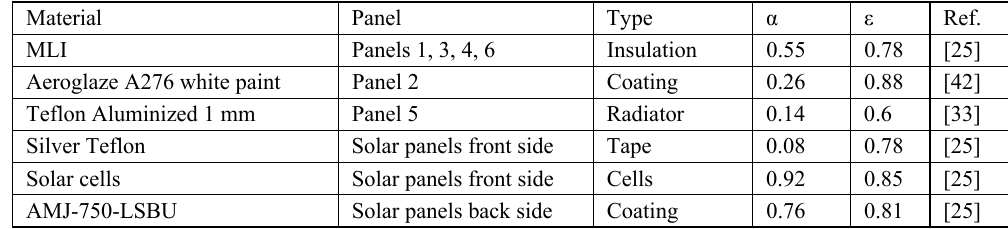
Table 5 External Optical